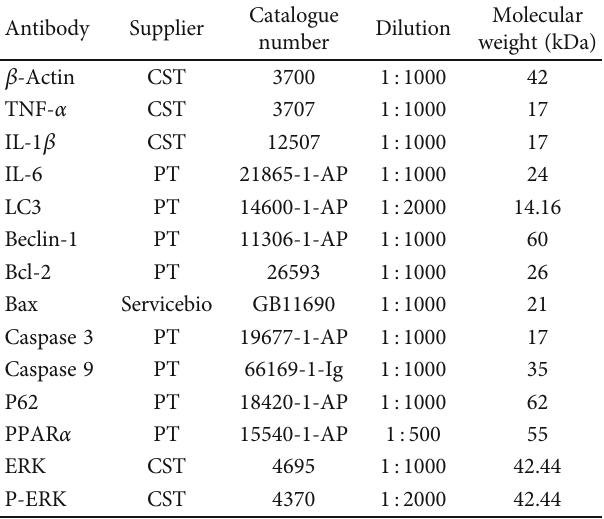
Table 1: The primary antibodies used for western blotting in the study. Antibody